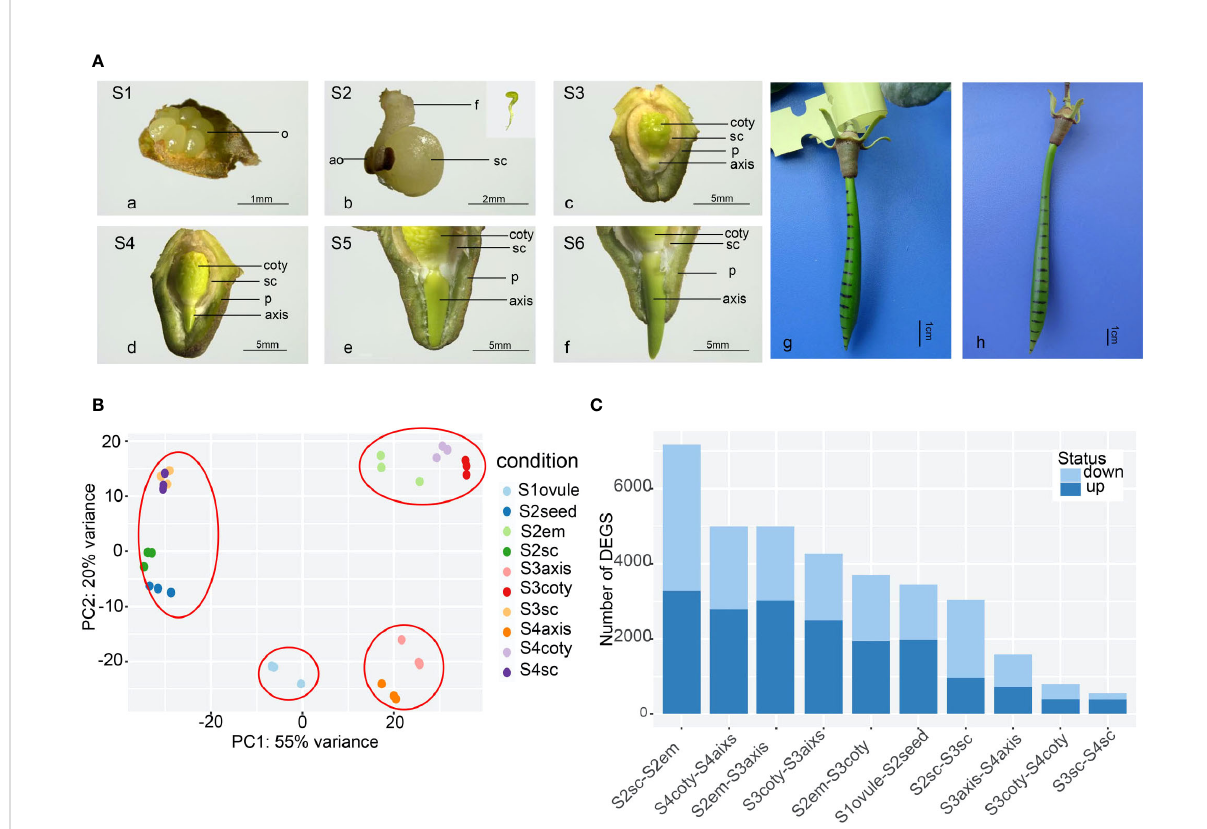
FIGURE 1 The reproductive process of viviparous and global gene-expression pattern in K, obovata . (A) The whole viviparous process from ovule to mature hypocotyl. (a) ovule stage (Stage1, S1); (b) enlarged growing seed (S2) and aborted ovules, the insert shows green and linear-shaped embryo; (c) developing seed about to germinate with the embryo enclosed in seed coat and pericarp (S3); (d) germinated seed whose axis protrudes out of the testa but within pericarp (S4); (e) elongating axis reached the edge of the pericarp (S5); (f) axis grows out of pericarp (S6); (g) with ink marked on hypocotyl in the fi eld, 40d later, the upper zone in (h) show expansion while the rest remain the same. ao, aborted ovule; coty, cotyledon; f, funicle; em, embryo; o, ovule; p, pericarp; sc, seed coat. (B) Principal Component Analysis (PCA) of gene expression of 10 samples showing the three replicates of each sample were cluster well. (C) Differential Express Genes (DEGs) numbers in pair-wise comparisons of different tissues and stages from more to less showing tissue heterogeneity are more obvious than stage